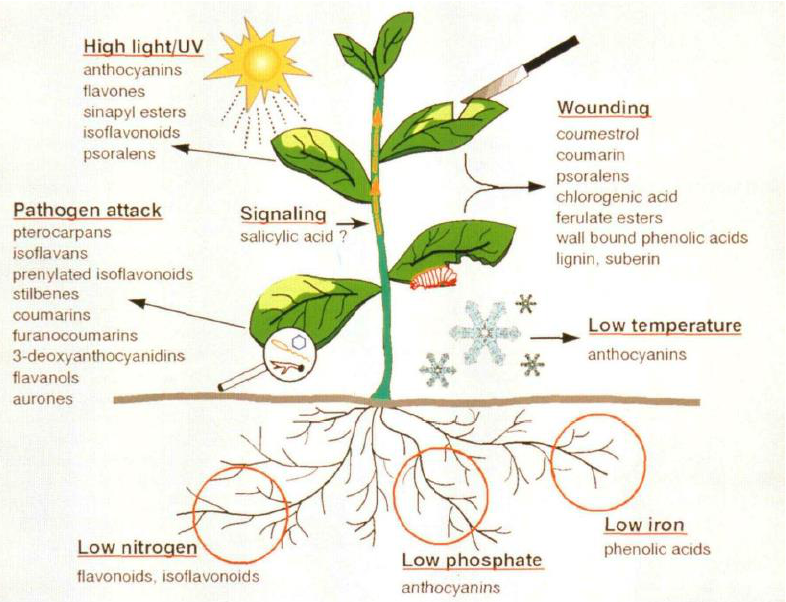
Figure 8. Examples of stress-induced phenylpropanoids. Source: Dixon and Paiva [100].